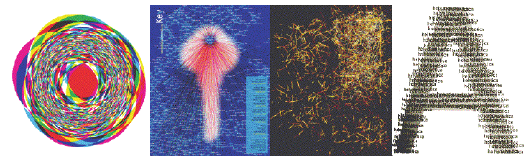
Figure 1 .: Maeda’s